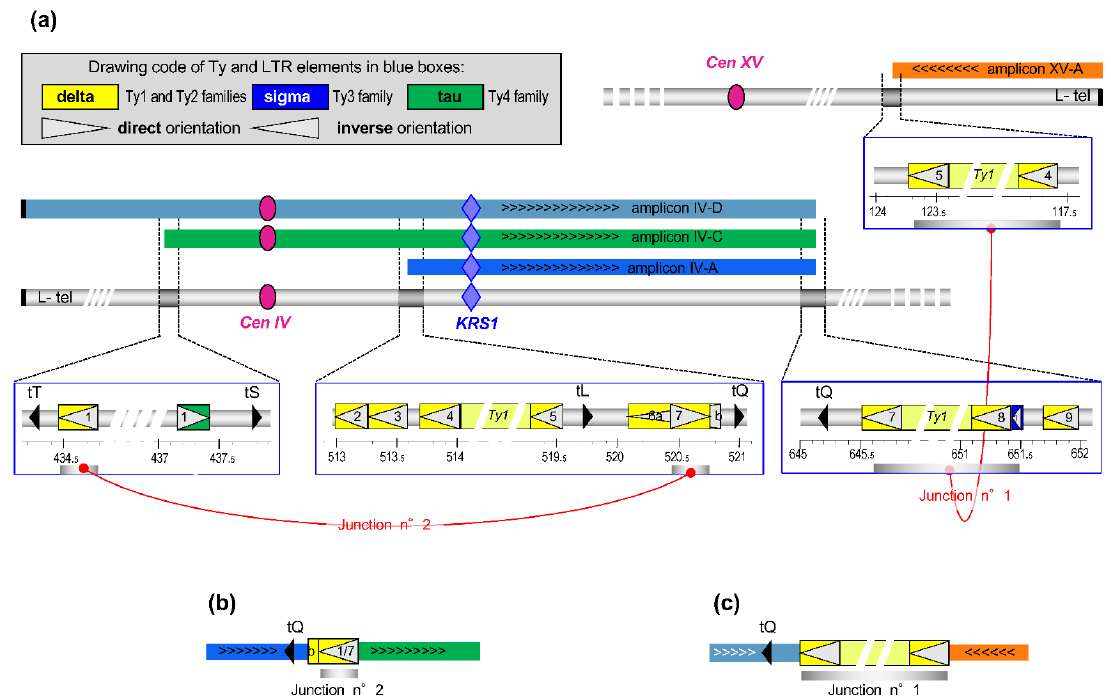
Figure 5. Junctions between amplicons. ( a ): Schematic representation of parts of chromosome IV and XV (silver horizontal bars) with amplicons (colored bars) and zooms on regions of amplicon ends (blue boxes) showing the presence of Ty elements, LTRs (drawing code in top insert) and tRNA genes (black triangles). Note the inverted orientation of chromosome XV to facilitate drawing. Elements involved in junctions are highlighted by shadowed bars joined by red lines. ( b ): junction n°2 between the left ends of amplicons IV-C and IV-A (inverted) occurred within LTR1 and LTR7. ( c ): junction n°1 between the right end of amplicon XV-A (inverted) and the right end common to amplicons IV-D, IV-C and IV-A occurred within the Ty 1 element.